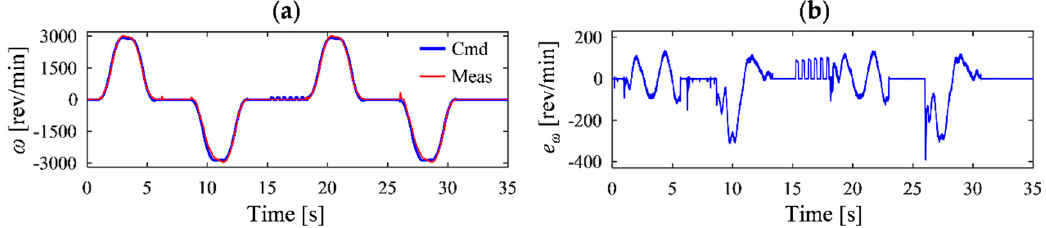
Figure 10. ( a ) Commanded and measured servo-motor speed; ( b ) Speed error.